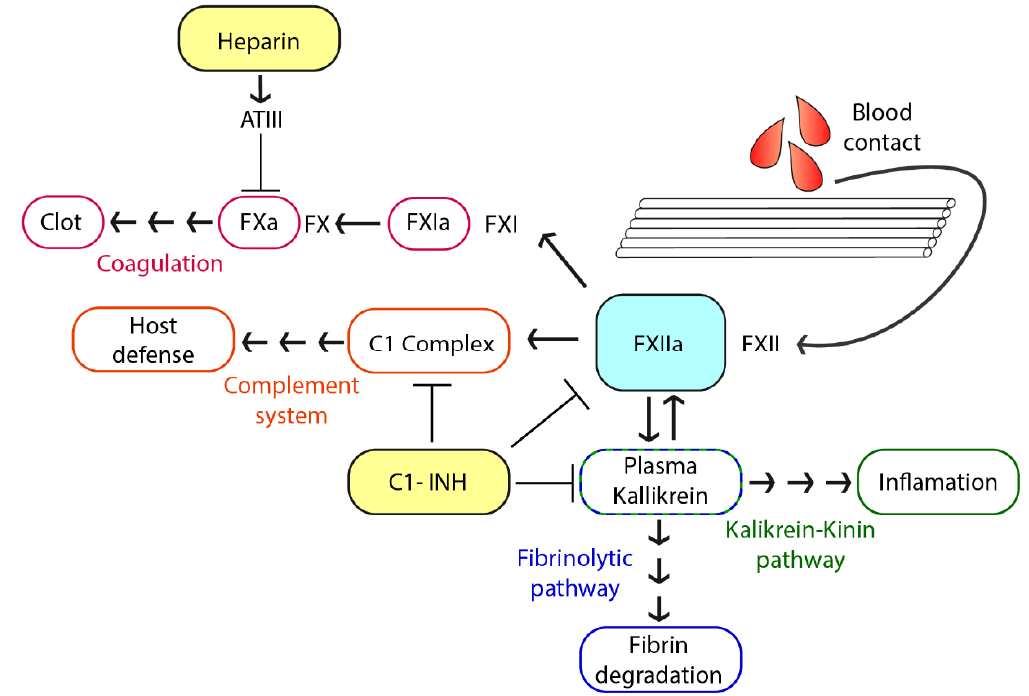
Figure 1. Schematic representation of the contact activation system. The contact of the blood with the artificial surface (polymethylpentene membrane) leads to the activation of factor (F) XII to FXIIa. FXIIa can then activate four di ff erent downstream pathways: (i) the coagulation pathway by cleaving the zymogen FXI to FXIa, eventually leading to thrombin activation and fibrin formation, (ii) the complement system by activation of the C1qrs-complex subunits C1r and C1s, (iii) the fibrinolytic pathway by plasma kallikrein activating plasmin to eventually degrade fibrin, (iv) the inflammatory kallikrein-kinin signaling pathway by plasma kallikrein cleaving high-molecular-weight kininogen liberating the pro-inflammatory molecule bradykinin [15]. Heparin and C1-INH are both able to inhibit one or more of these pathways. While heparin only inhibits coagulation, C1-INH positively a ff ects coagulation, the complement system, fibrin degradation, and inflammation [16,24].